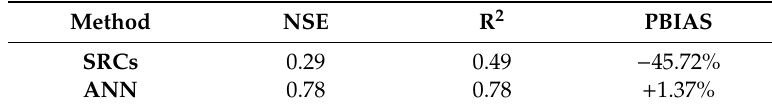
Table 1. Statistical analysis of the performance of the sediment ratings curve (SRC) and artificial neural network (ANN) models in predicting the daily suspended sediment